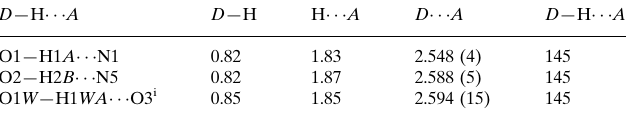
Hydrogen-bond geometry (A˚ , (cid:2)